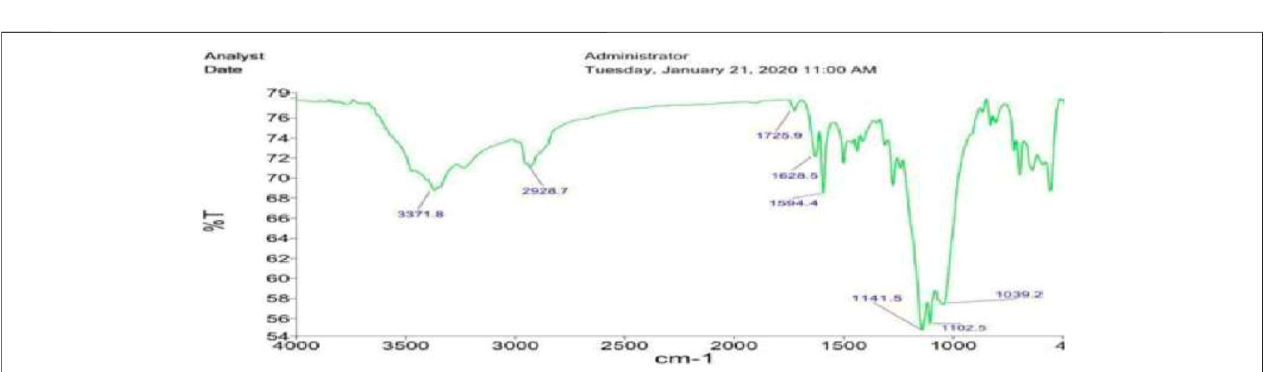
FIGURE 2 | FT-IR spectra of Fe 3 O 4 @SiO 2 -propyl@dapsone-Cu MNPs.